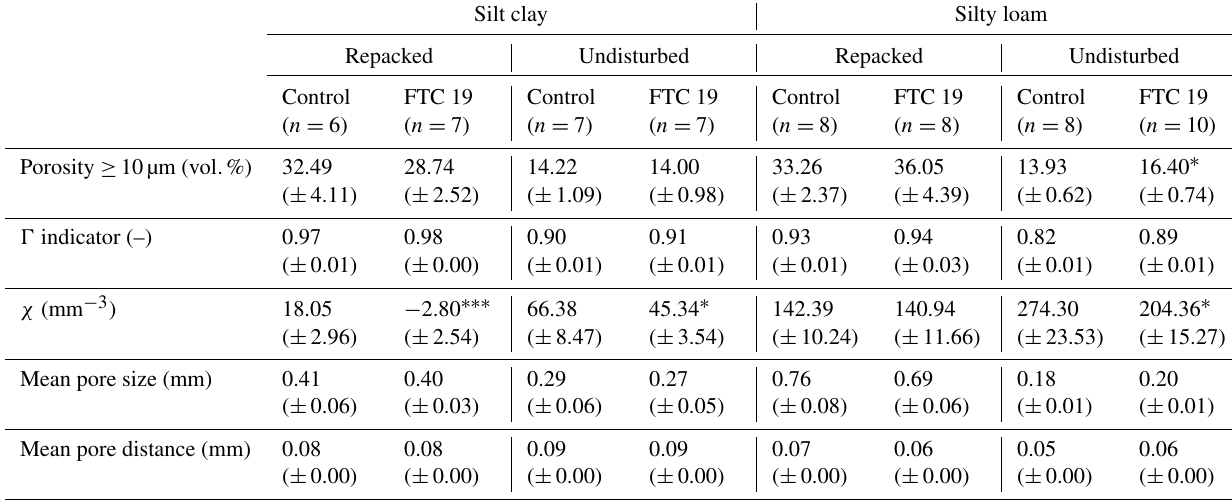
Table 3. Soil structural parameters as arithmetic means and their standard errors determined via X-ray µCT at a resolution of 10µm. Silt clay Silty loam Repacked Undisturbed Repacked Undisturbed Control